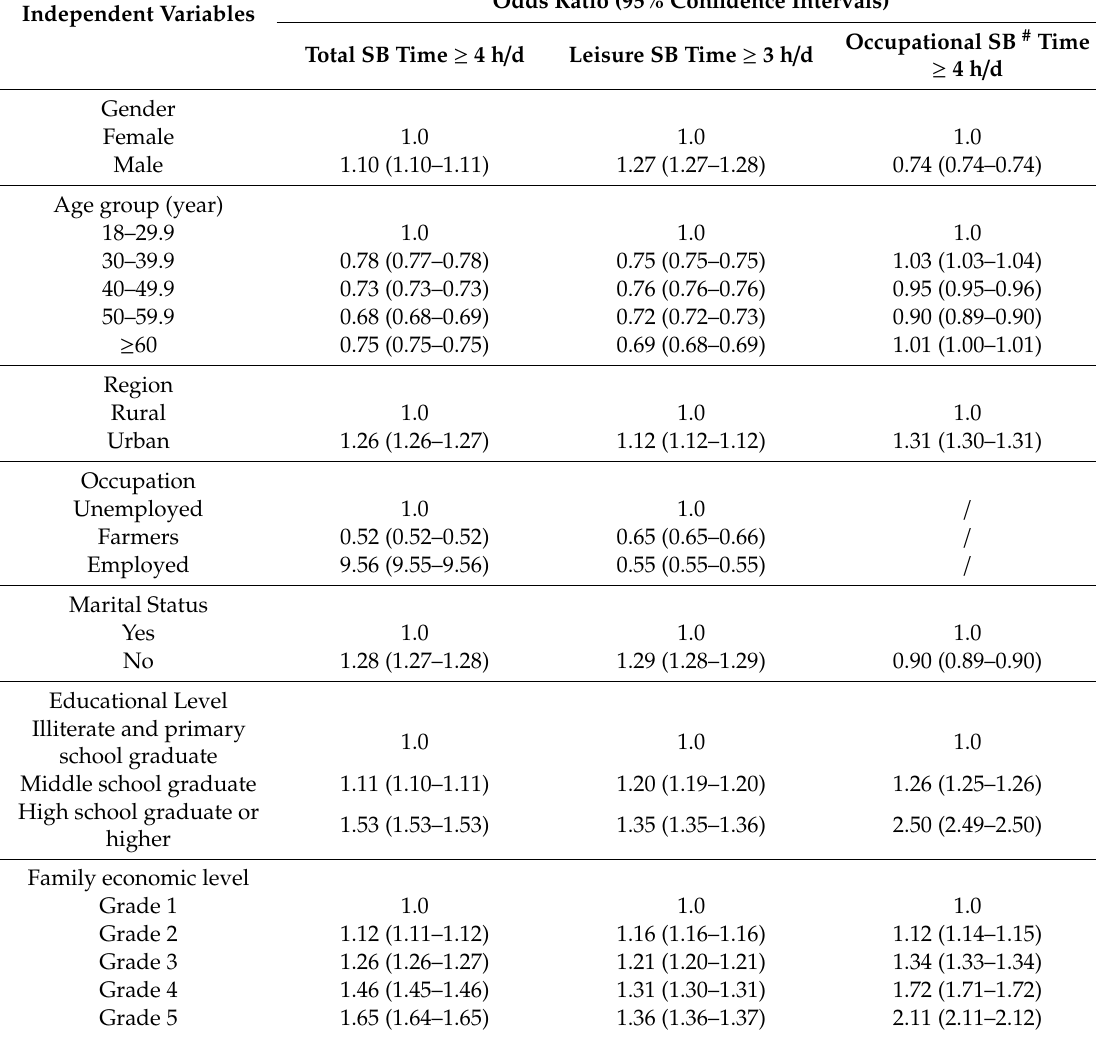
Table 4. Correlates § of total SB time ≥ 4 h / d, leisure SB time ≥ 3 h / d, and occupational SB # time ≥ 4 h / d among Chinese adults in 2010–2012 ( n =